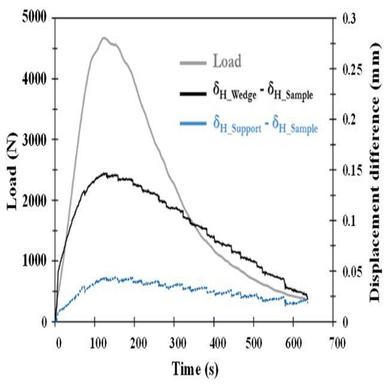
Difference in crack opening displacement δH versus time during a WST, between Wedge and Sample methodologies, and between Support and Sample methodologies.